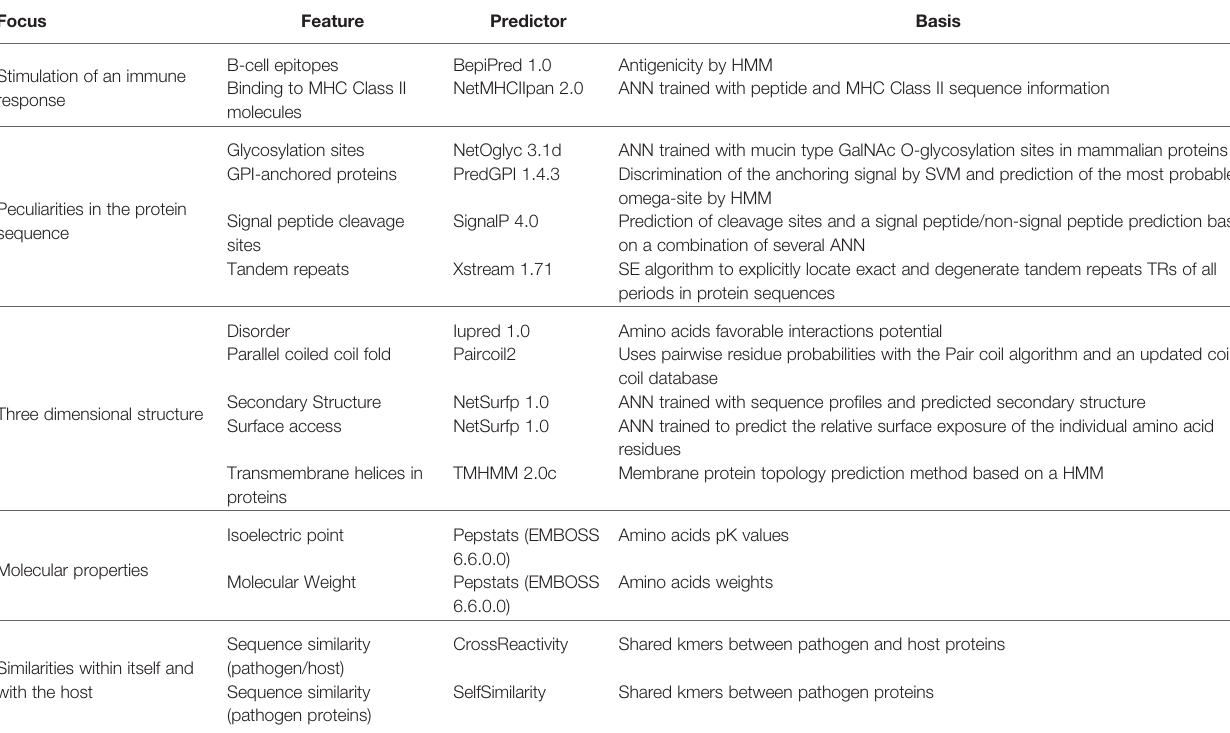
TABLE 2 | Predictors used to analyze different features of proteins and